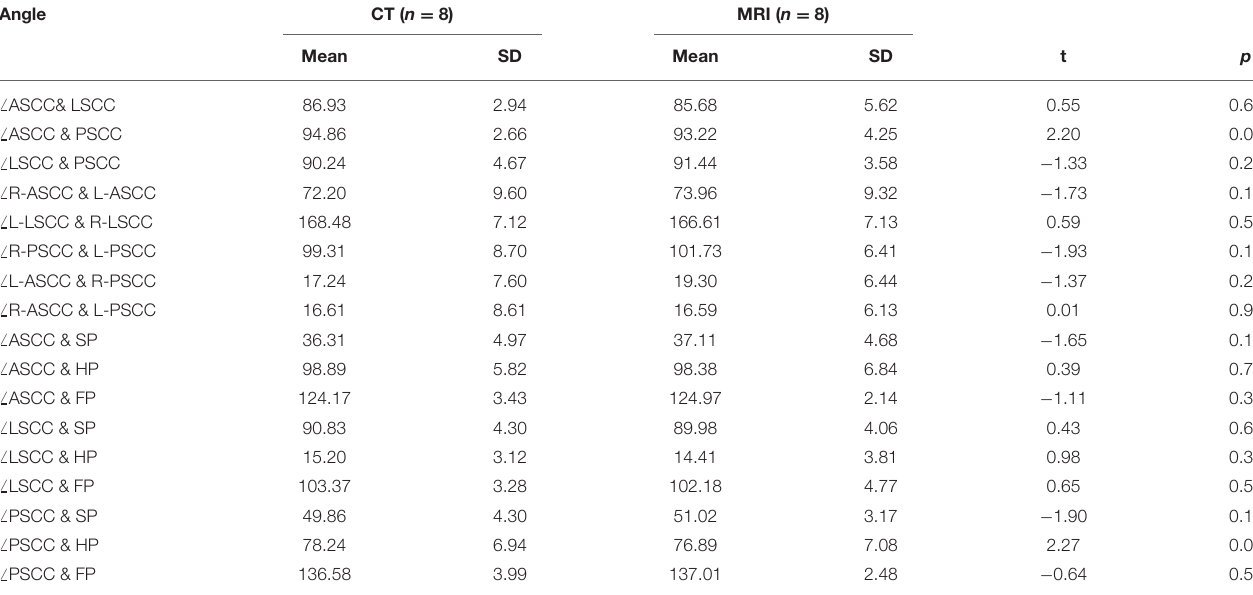
TABLE 4 | Angles (degrees) measured in the same patient between the planes of the semicircular canals and between the canal planes and the imaging planes.